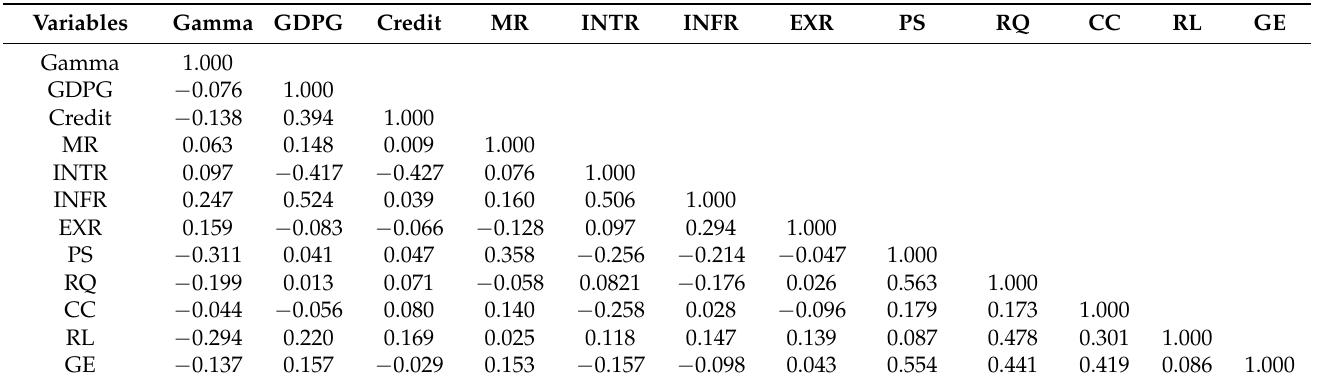
Table 3. Pearson’s correlation matrix.